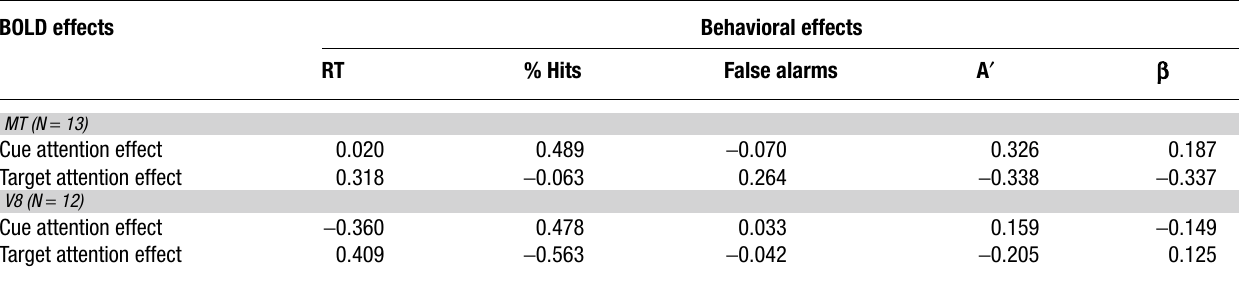
Table 3. Correlations between the effect of attentional cuing on hemodynamic (BOLD) responses and behavior during motion trials. BOLD effects